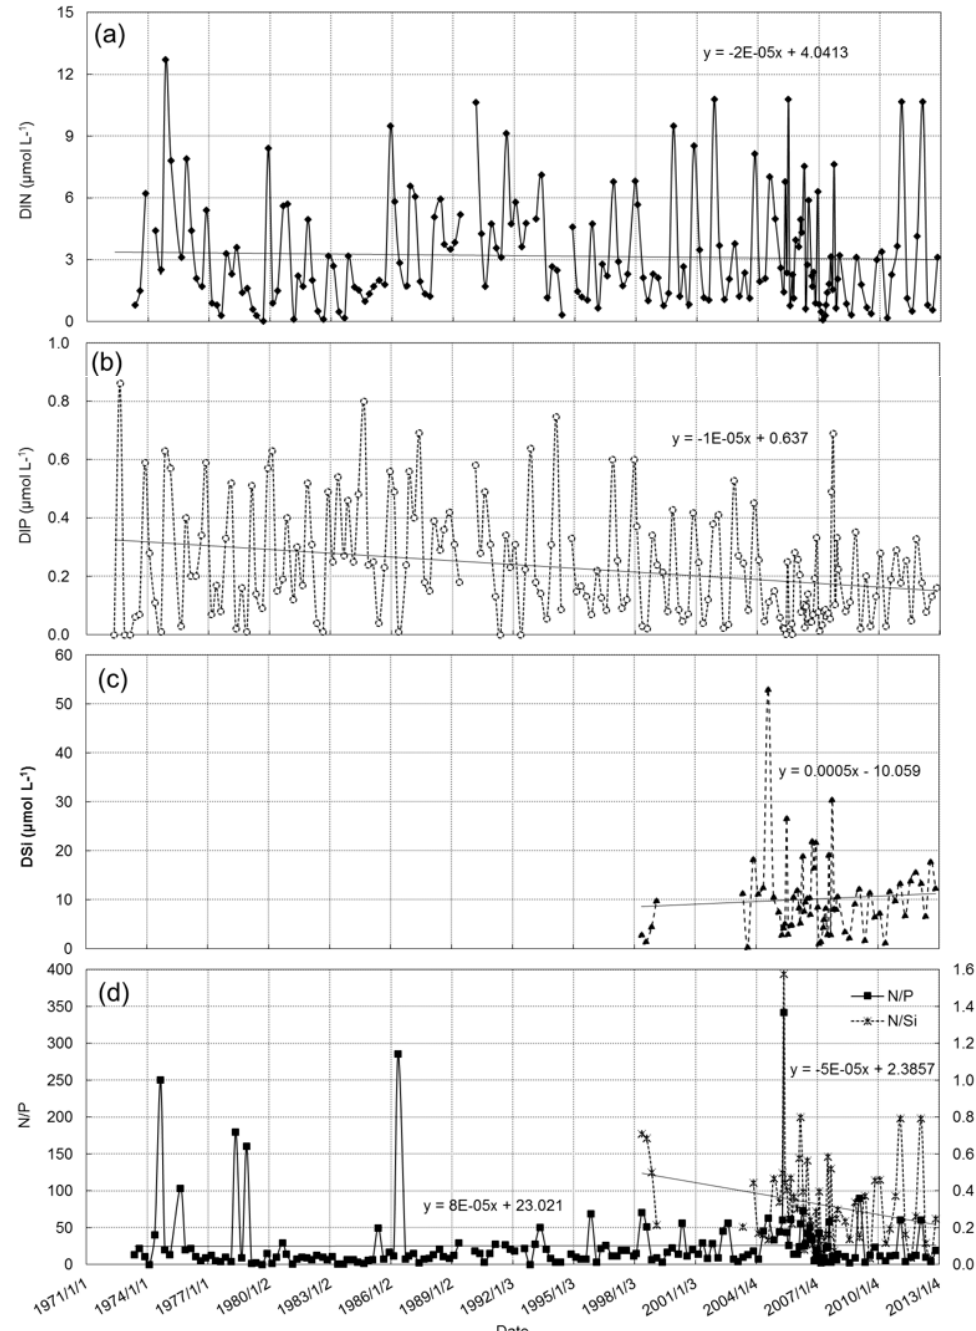
Figure 3. Variations in dissolved inorganic nitrogen (DIN) (a) , dissolved inorganic phosphorus (DIP) (b) , dissolved silica (DSi) (c) and ratios between nitrogen and phosphorus (N / P) and nitrogen and silica (N / Si) (d) in the coastal seawater from 1972–2012.